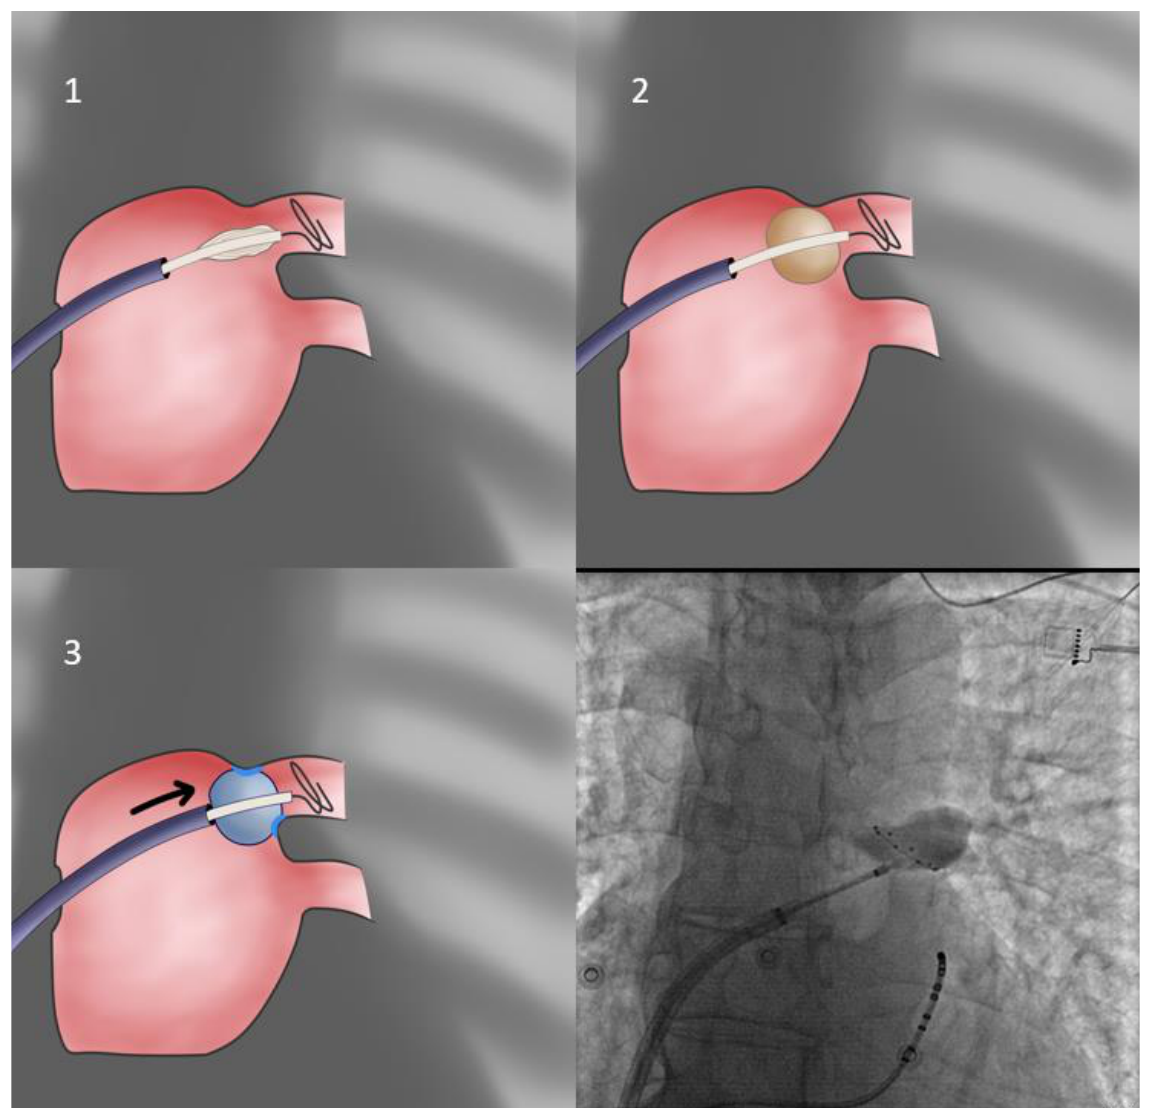
Figure 1. Direct approach. In this most basic technique, the catheter sheath is used to apply pressure to the balloon, leading to vein occlusion. Care must be taken to avoid pushing the balloon inside the venous ostium, leading to suboptimal isolation. Flexion of the balloon sheath itself may also be required (see text for further details).